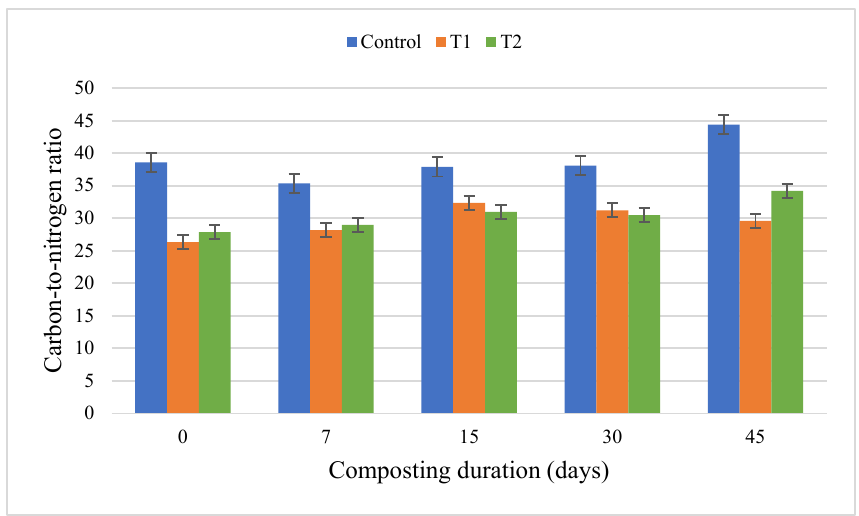
Figure 11. The C/N ratio changes in control, T1, and T2 samples at 0, 7, 15, 30, and 45 days.